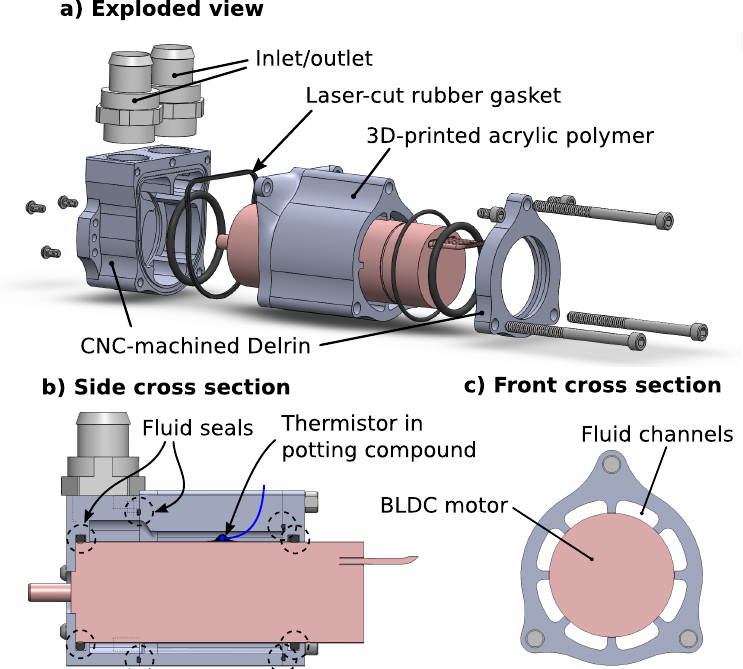
Figure 3. Design of a casing to house and circulate cooling fluid around the Maxon EC22 100-W